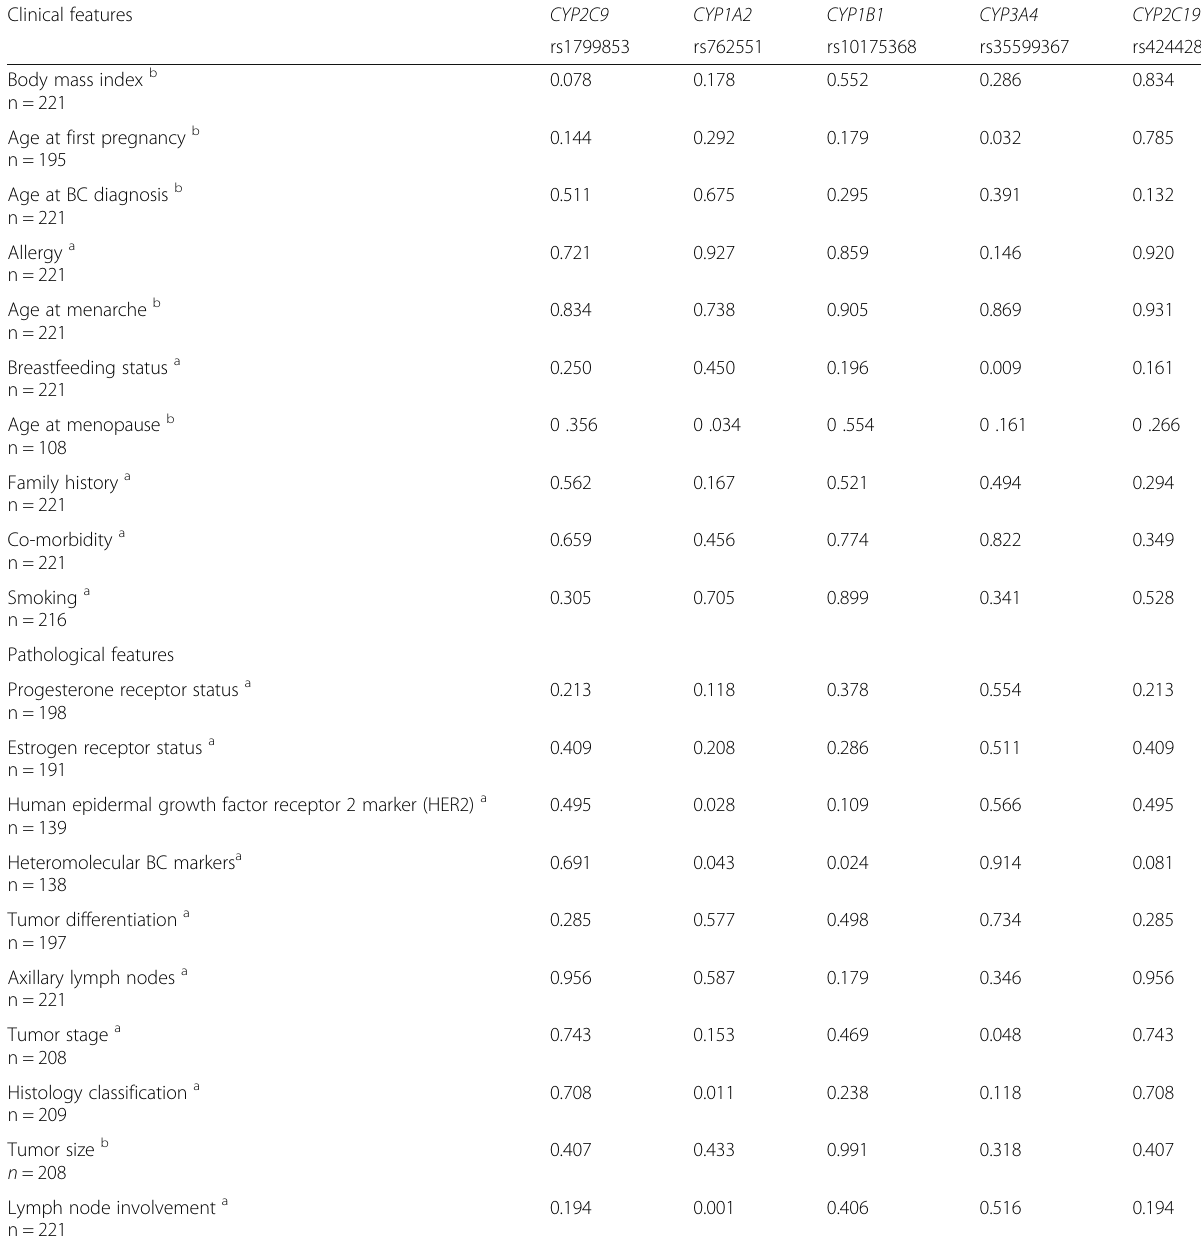
Table 6 Association between different CYP2C9, CYP1A2, CYP3A4 and CYP2C19 SNP genotypes and the clinico-pathological features of breast cancer